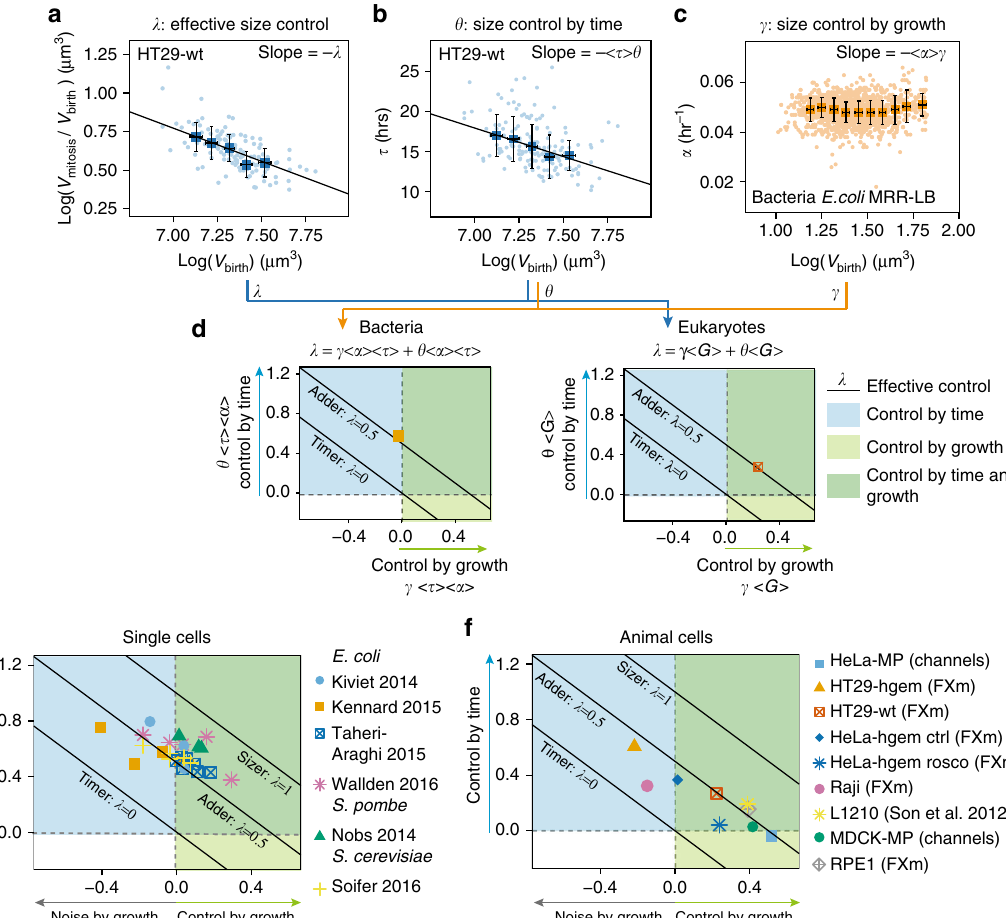
Fig. 7 Contribution of growth and time modulation in overall size control. a Replicative growth, log( V mitosis / V birth ) vs. logarithm of volume at birth log( V birth ) for HT29-wt cells. The slope coef fi cient of the linear regression gives − λ and indicates the strength of the effective size control ( − λ = − 0.5 ± 0.002, R 2 = 0.85, n = 132, N = 3). b Cell cycle duration τ vs. initial volume log( V birth ) for HT29-wt cells. The slope coef fi cient of the linear regression gives − 〈 τ 〉〈 θ 〉 , with 〈 τ 〉 the average cell cycle duration and θ the strength of control by time modulation. A positive value of θ corresponds to a positive effect on size control ( 〈 − τ 〉 θ = − 7 ± 0.2, R 2 = 0.88, n = 163, N = 3. c Growth rate α vs. volume at birth log( V birth ), for a dataset on bacteria from ref. 51 . The slope coef fi cient of the linear regression gives − 〈 α 〉〈 γ 〉 , with 〈 α 〉 the average growth rate and γ the control due to growth rate modulations. A positive value of γ corresponds to a positive effect on size control ( − 〈 α 〉 γ = − 0.0005 ± 0.0002, R 2 = 0.06, n = 2107). d Left: plot of θ 〈 τ 〉 〈 α 〉 , vs. γ 〈 τ 〉 〈 α 〉 for the bacteria dataset shown in Fig. 7c. Positive values along both y and x axes correspond to a positive effect on size control via time or growth modulation respectively. Right: plot of θ multiplied by 〈 G 〉 , the average replicative growth 〈 G 〉 = 〈 log( V mitosis )/log( V birth ) 〉 , vs. γ multiplied by 〈 G 〉 for HT29-wt cells shown in a and b . e Comparison of datasets for bacteria (data from refs. 8, 50 – 52 ) and yeasts (data from refs. 11, 16 ), plotted as in d . Each point corresponds to a different growth condition (see Supplementary Fig. 8d). f Comparison of datasets for animal cells (our results and data from ref. 30 .), plotted as in Fig. 8d. a , b , c Dots are single-cell measurements, squares with error bars are median bins with s.d., and black lines show the linear regression performed on the median bins weighted by the number of observations in each bin. d – f The dashed lines indicate the threshold above which time modulation (horizontal line) and growth modulation (vertical line) have a positive effect on size control. Values are given as slope ± standard error. See also Supplementary Figure